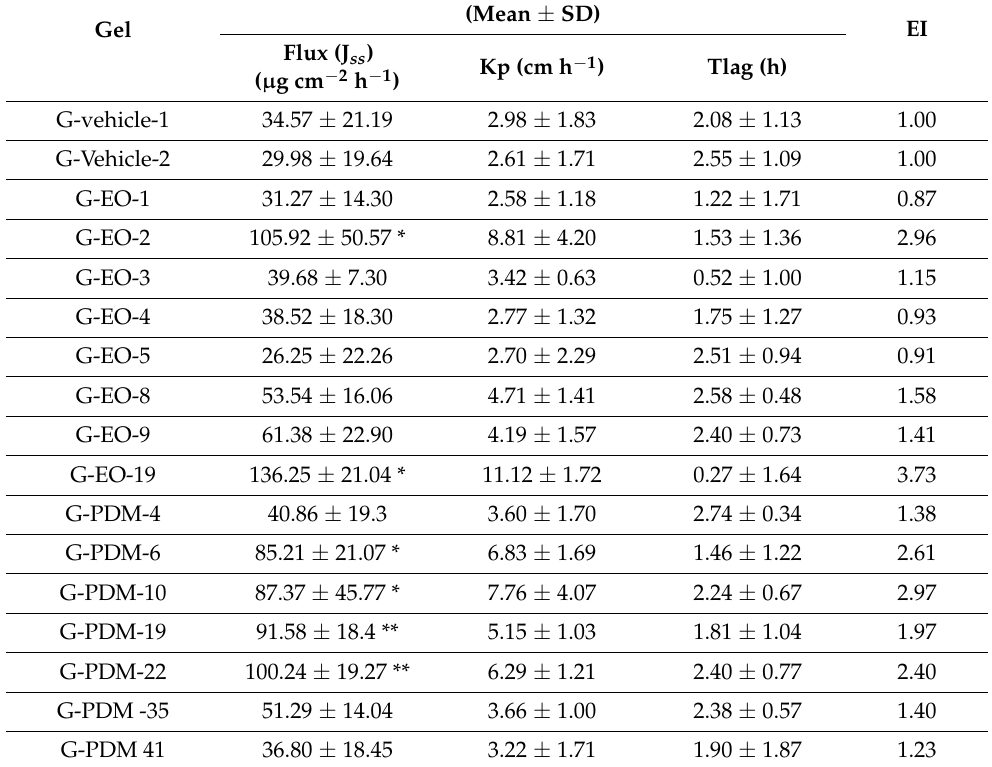
Table 3. Effect of essential oils (EOs) and plant-derived metabolites (PDMs) at 1% w / w on the permeation parameters of caffeine using mouse skin ( n =